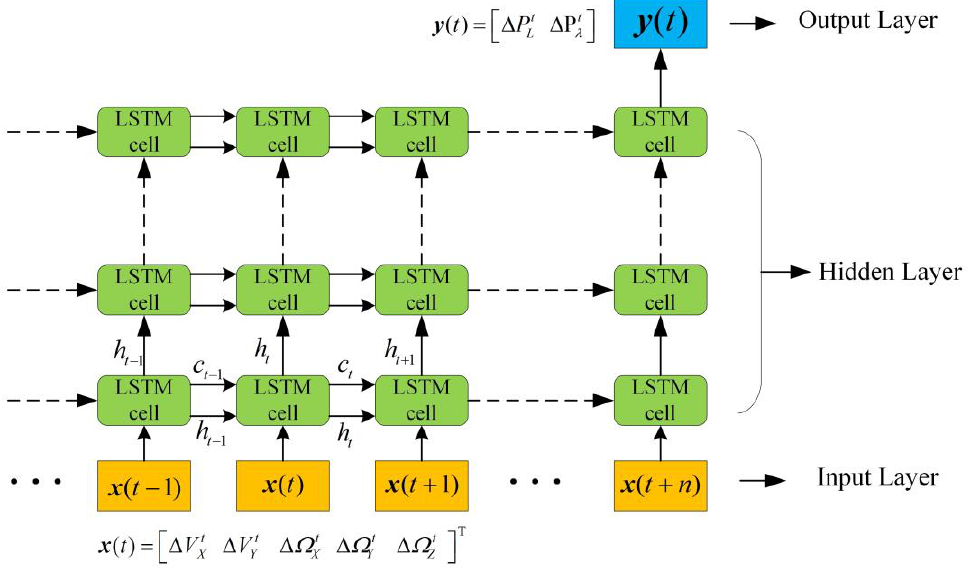
Figure 6. LSTM block diagram for constructing virtual sensor.